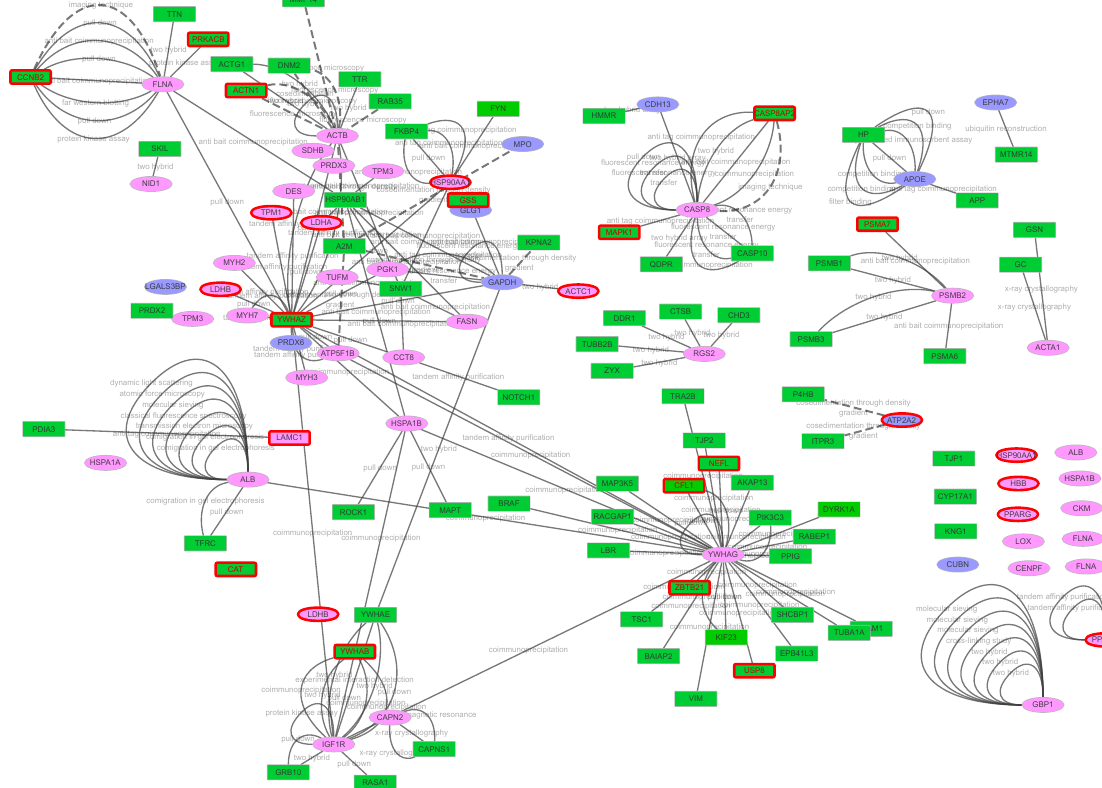
Figure 4. Network of the 71 plasma proteins identified in this study as putative candidate biomarkers for beef tenderness. This network reports the 71 plasma proteins identified as candidate biomarkers for meat tenderness in this study. The 13 predicted secreted proteins in plasma (conventional and alternative pathways) are shown in purple ellipse. The 44 hypothetically secreted proteins in plasma are shown in pink ellipse. The green rectangle refer to interactor identified through the up to date Cytoscape tool (MINT resource, Psciquic web service, 2017-12-17). The border red rectangle refer to the interactors located in cattle meat QTL for Shear force and / or Tenderness score tenderness (ProteINSIDE ProteoQTL analysis). Solid line shows the “primary interaction type”. Dotted line shows the interaction through “detection method”. Eleven out of the 57 plasma candidates (ATP5B, BPGM, COL11A1, COL13A1, ENO3, FGF12, LRRC16A, PCDH7, PGAM2, PVALB and TG), not included in the MINT database, are not shown in this